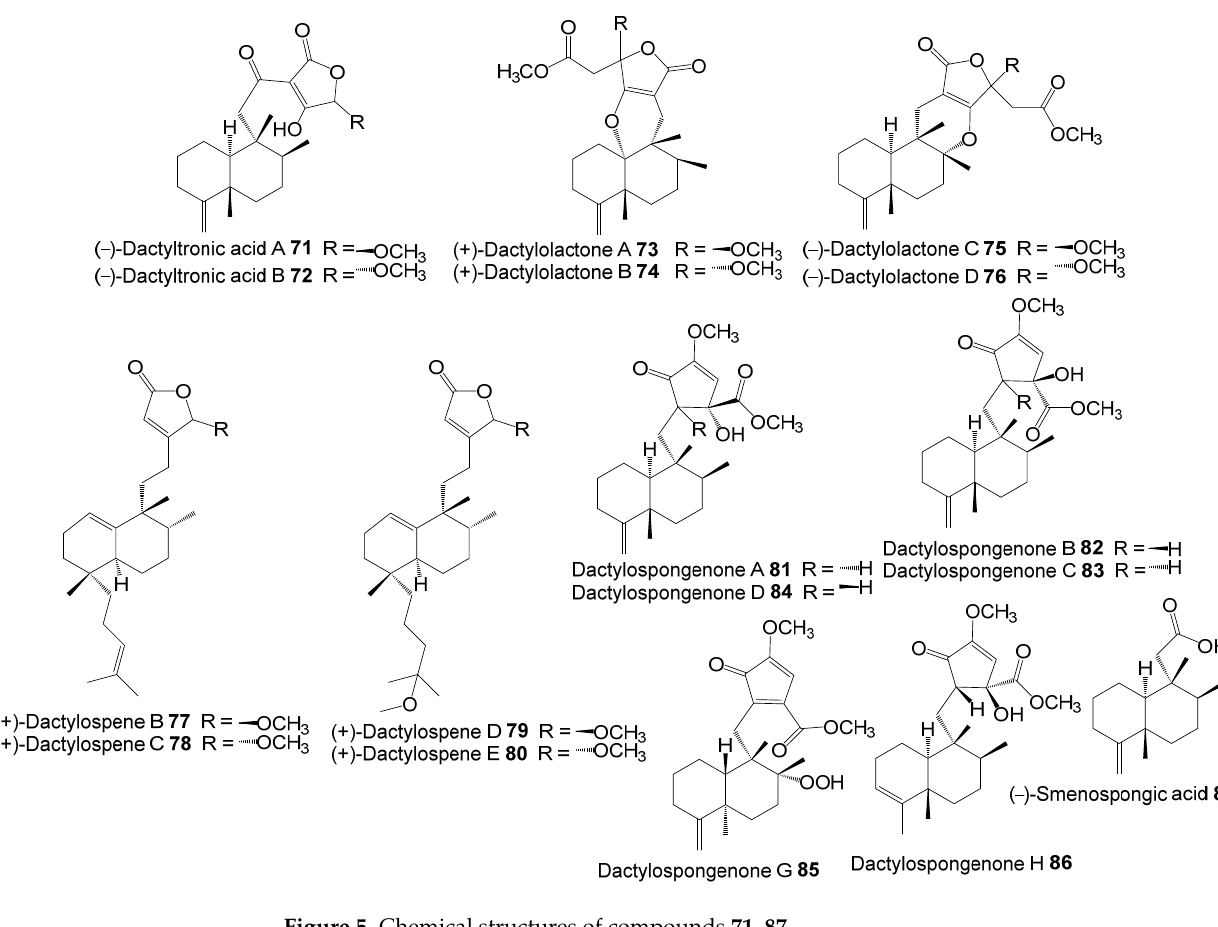
Figure 5. Chemical structures of compounds 71 – 87 .